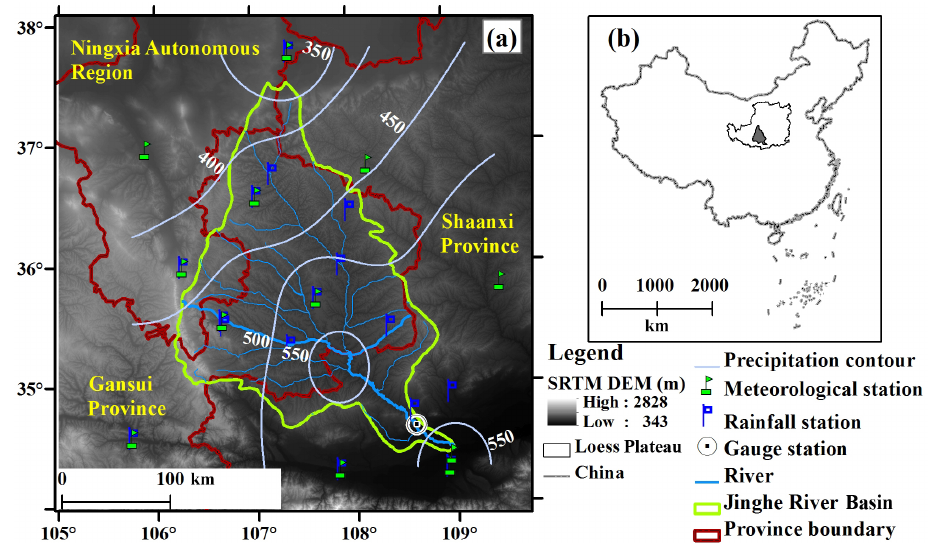
Figure 1. Geographic information regarding the study area: (a) location and SRTM DEM of the Jinghe River basin and (b) schematic of the selected study area in China. Precipitation (mm) is averaged and interpolated from meteorological data between 1970 and